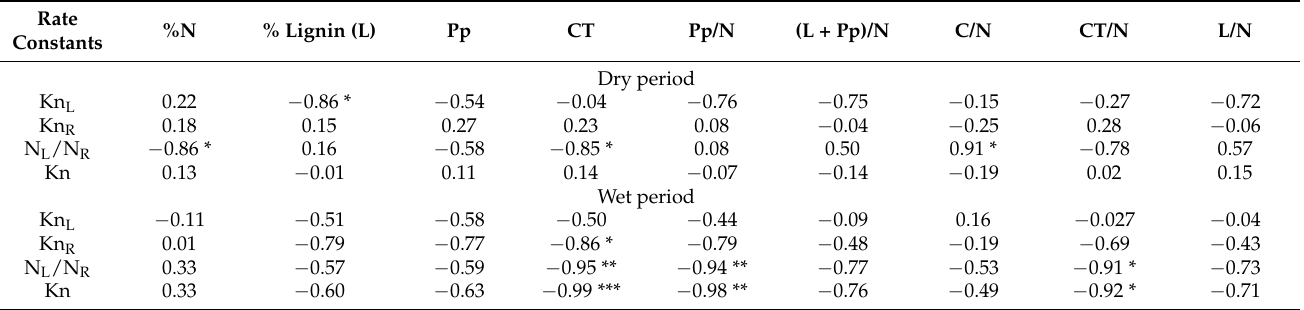
Table 4. Correlation coefficients (r) among N release and leaf chemical quality for the dry and rainy